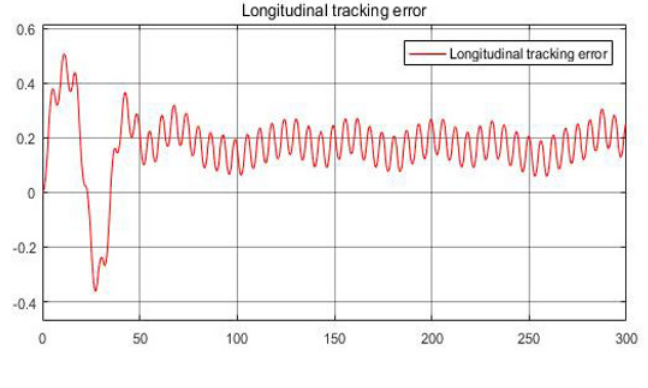
Fig. 6. First-order system for UAV trajectory tracking(two).